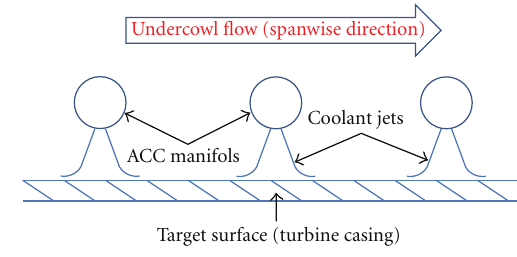
Figure 6: Spanwise direction.